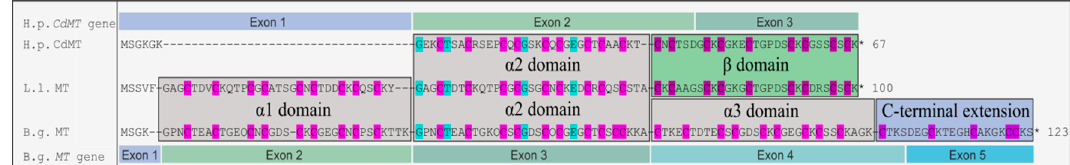
Figure 3. Alignment of the CdMT of Helix pomatia (H.p.) (GenBank acc. Nr.: AF399740.1), the MT of Littorina littorea (L.l.) (GenBank acc. Nr.: AY034179.1) and the MT of Biomphalaria glabrata (B.G.) (GenBank acc. Nr.: KT697617) displaying the amino acid sequence and suggested domain structure. Exon structures of the genes are shown for Helix pomatia (H.p. CdMT gene) (GenBank acc. Nr.: FJ755002.1) and for Biomphalaria glabrata (B.g. MT gene) (GenBank acc. Nr.: XM_013225031). Conserved cysteines are marked in pink. Conserved amino acid positions shared by all MTs are marked in blue. The α -domains are indicated by a grey box, β -domains by a green box and the C-terminal extension is marked by a blue box. Exon structures of the genes are indicated by colored boxes above (for H.p.) and underneath (for B.g.) the respective amino acid sequence. Additionally, the length is indicated at the end of each sequence.